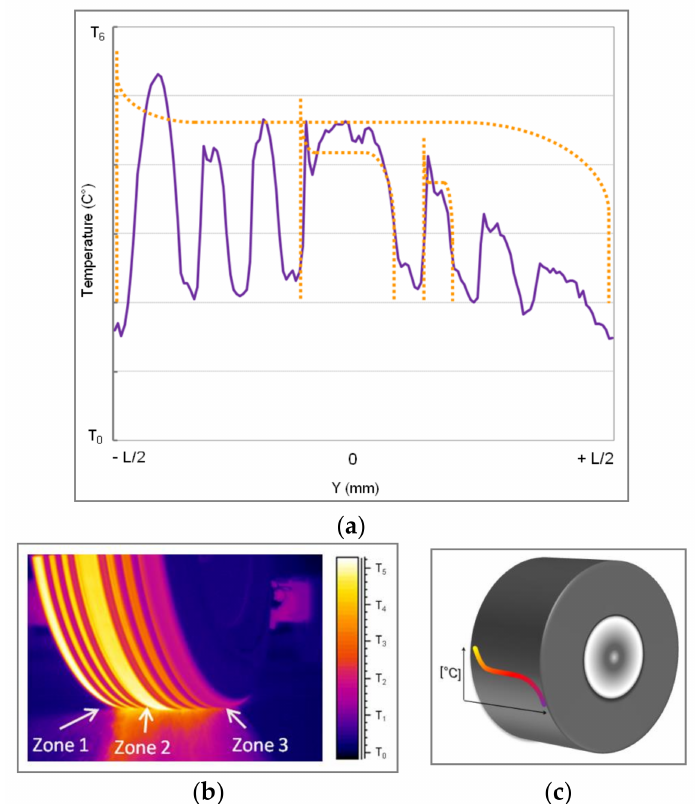
Figure 10. Experimental measurements: ( a ) thermal evolution of an aircraft tire tread rolling on a standard runway, ( b ) image of contact zone, infrared camera acquisition, ( c ) typical S-profile of thermal evolution of tire tread rolling on a flat